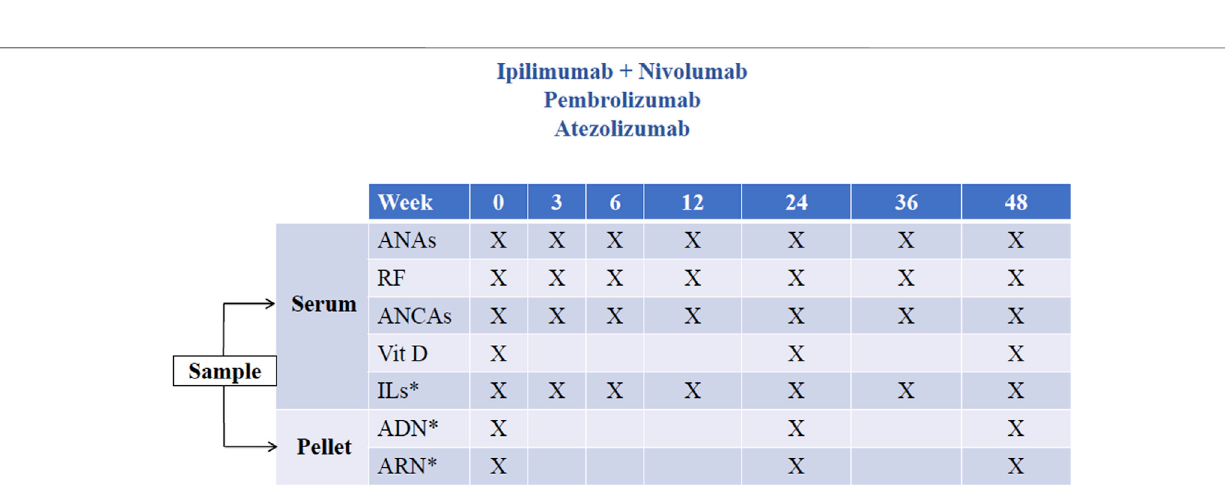
Frontiers in Pharmacology |